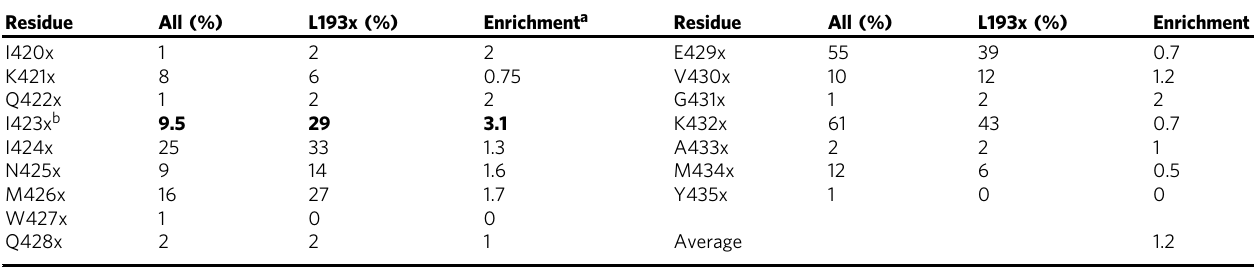
Table 1 Frequency of non-consensus amino acids in each of the β 20 – β 21 residues among 2500 primary HIV-1 strains (All) and among those HIV-1 strains that contain a residue other than leucine at position 193 (L193x)